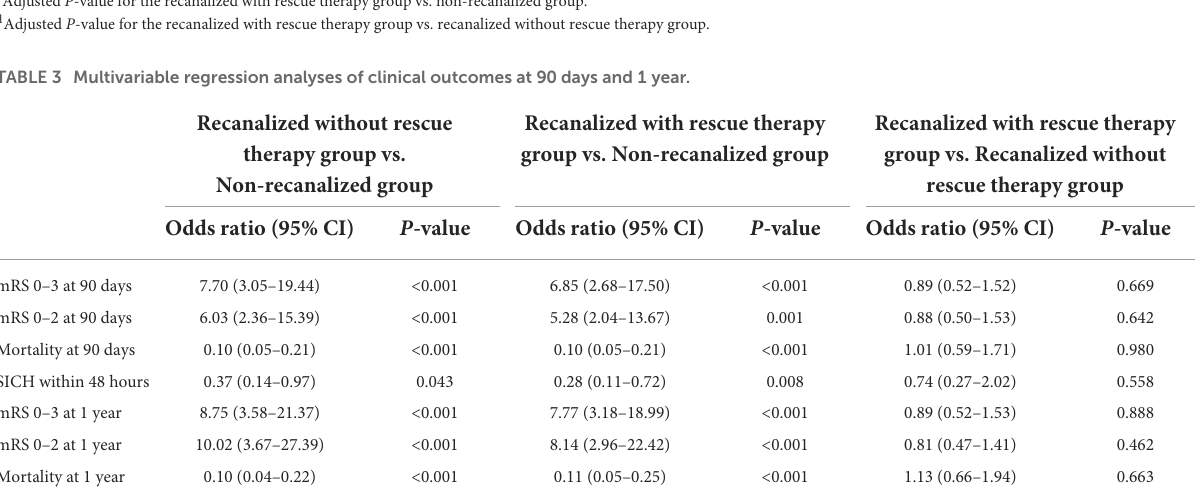
TABLE 3 Multivariable regression analyses of clinical outcomes at 90 days and 1 year. Recanalized without rescue Recanalized with rescue therapy therapy group vs. group vs. Non-recanalized group Non-recanalized group